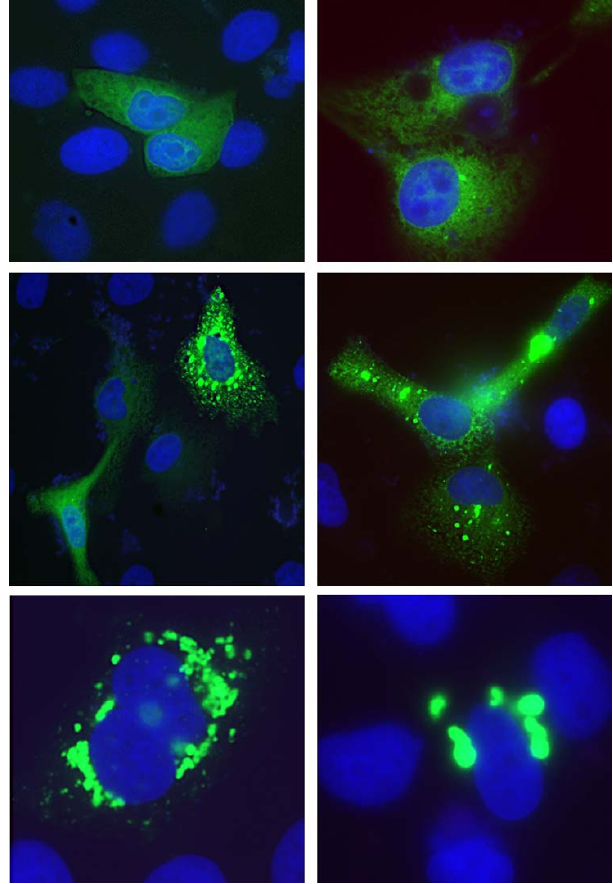
Figure 5 GFP-F538 localize to the cytoplasm of transfected CV1 cells. Depending on the level of expression it shows homogeneous (5–8 hours after transfection – top row), speckled (24 hours after transfection – middle row) or massively granular distri- bution (48 hours after transfection – bottom row). DNA staining with Hoechst 33258 is